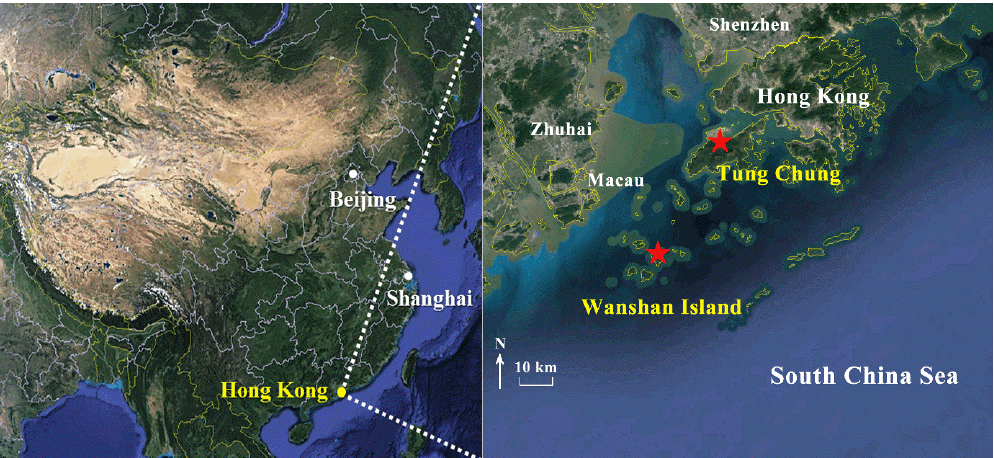
Figure 1. Locations of the sampling sites (red stars) and the surrounding